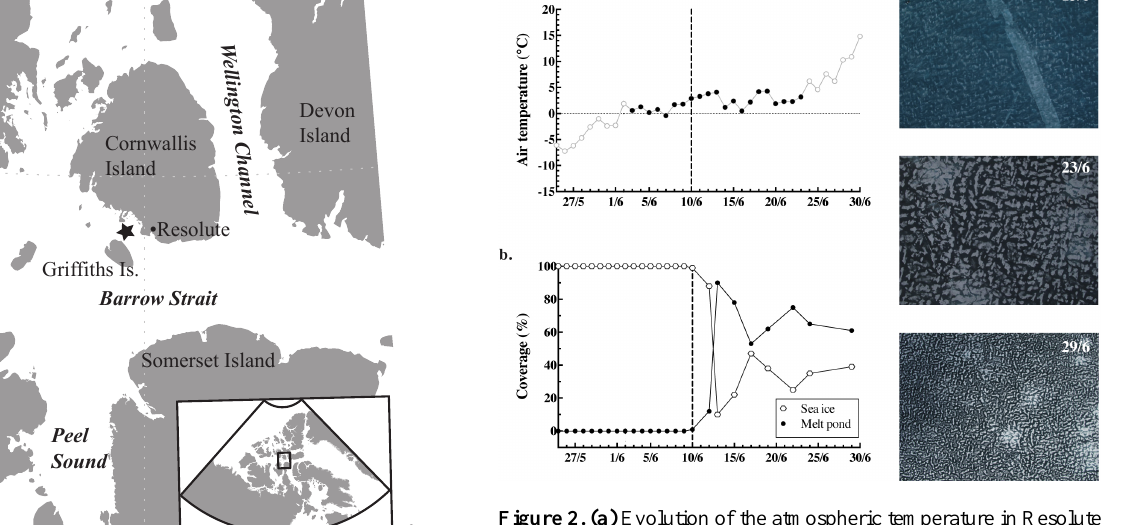
Figure 2. (a) Evolution of the atmospheric temperature in Resolute from the end of May to the end of June 2012. The black dots rep- resent the air temperature during our survey (from 3 to 23 June). (b) Evolution of the melt ponds (black dots) and sea ice (white dots) fraction coverage at the sampling site. The bold dashed line on 10 June represents the initial formation of melt ponds at the sur- face of the ice cover. Aerial photos were taken over the field study site on 13 June (pond fraction = 0.9; width of the picture = 4472m), 23 June (pond fraction = 0.65; width of the picture = 2212m), 29 June (pond fraction = 0.61; width of the picture =